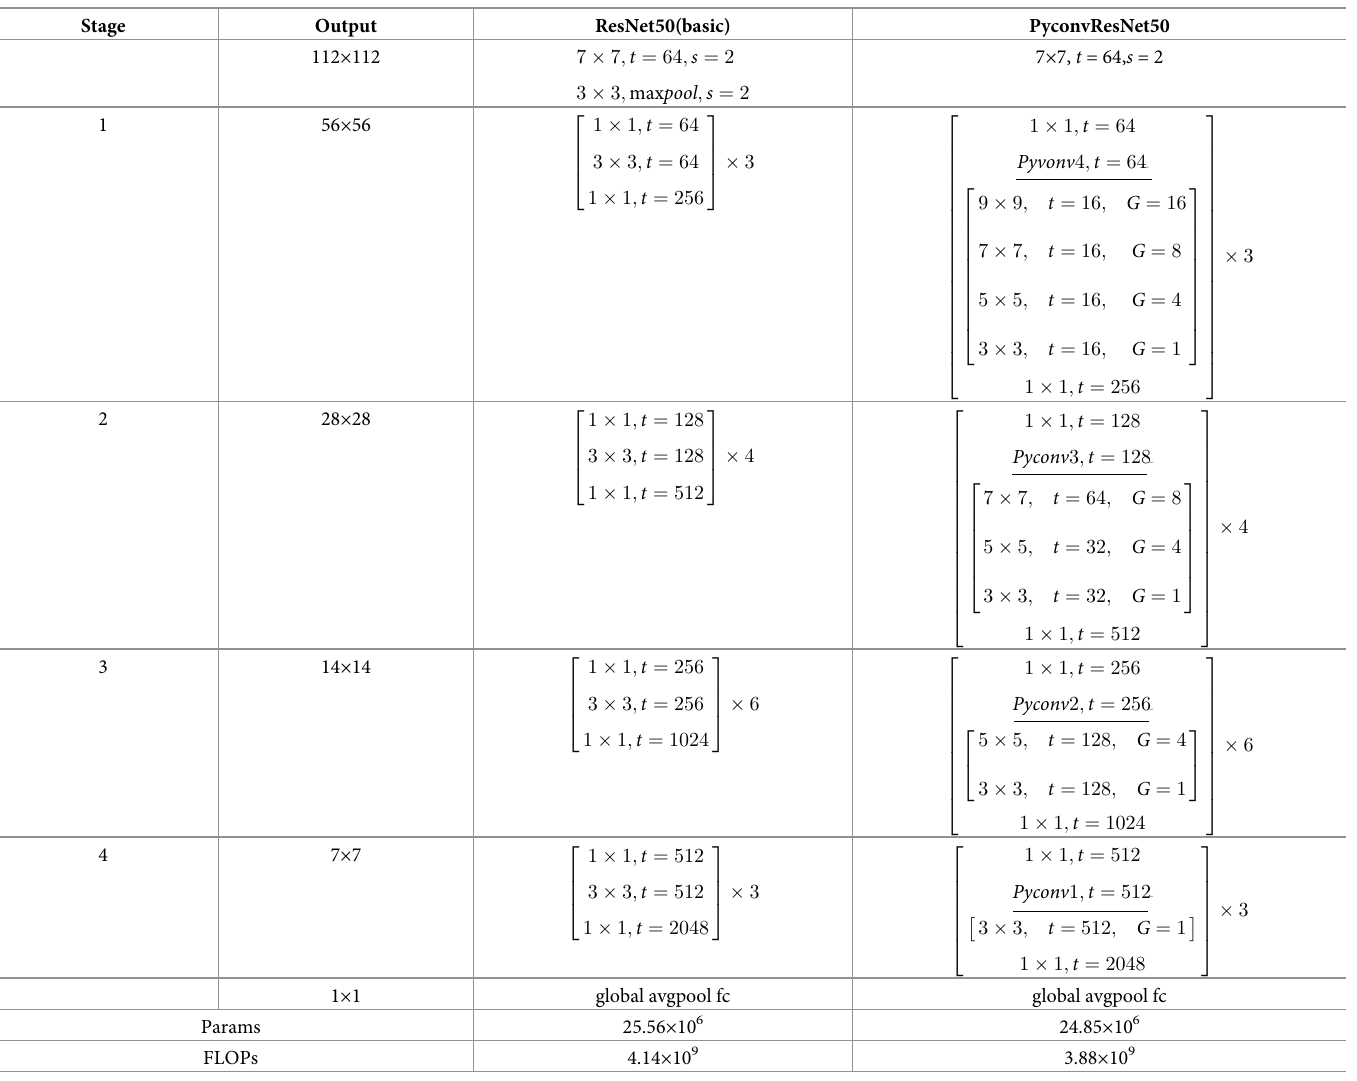
Table 1. PyconvResNet50 convolution kernel size information.